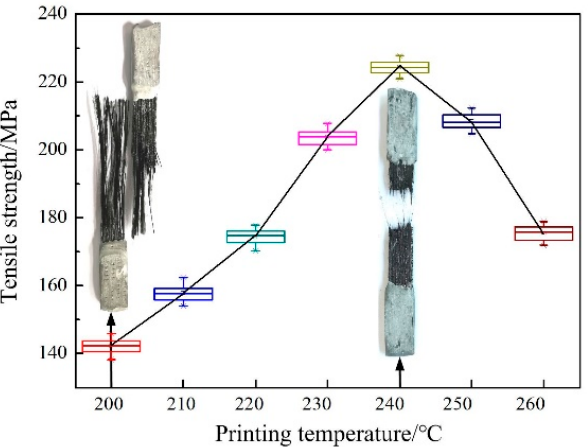
Figure 9. The test results of the tensile properties of the three-layer entities prepared at different printing temperatures and the photos of the specimens after pulling.